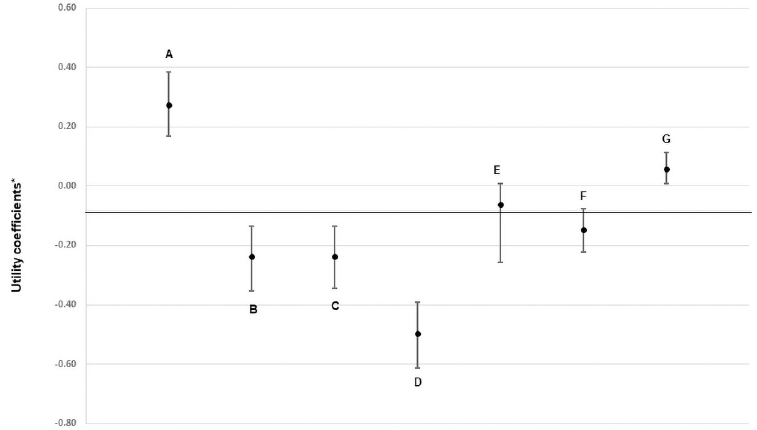
Fig 3. Directionality of PrEP access preferences among 236 young men who have sex with men � . � Negative numbers indicate an option that was less preferred than the baseline option. Attributes: A. Insurance covered, compared to not covered; B. Requires new insurance, compared to not covered; C. Requires extra (supplemental) insurance, compared to not covered; D. Insurance not private (services used can be seen by family or employers), compared to private; E. Wait 1 week to start PrEP, compared to immediate start; F. Wait 4 weeks to start PrEP, compared to immediate start; G. Communicate online with provider, compared to in-person visits.